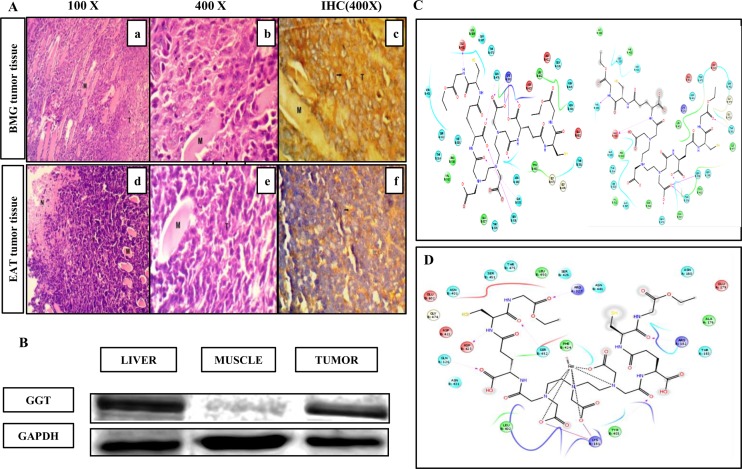
Estimating the expression of GGT ex vivo and in silico docking studies A)The upper panel images shows BMG-1 tumor tissue histology (a & b) 100X and 400 X magnification micrograph of H& E stained tissue sections.(c) IHC to probe GGT expression on BMG-1 tumor tissue, 400 X. Lower Panel images show EA tumor histological images. (d & e) 100X and 400X magnification images of H & E stained EA tumor tissue sections (f) 400X image showing moderately positive expression of GGT in EA tumor. B) Representative western blot showing the expression of GGT and GAPDH in three tissue types (Liver, muscle, tumor). C) Two dimensional view of two conformations of DT(GSHMe)2 and D) Re-DT(GSHMe)2 with 4GG2 where green color represent hydrophobic, light blue are polar, red as positive charged residues.